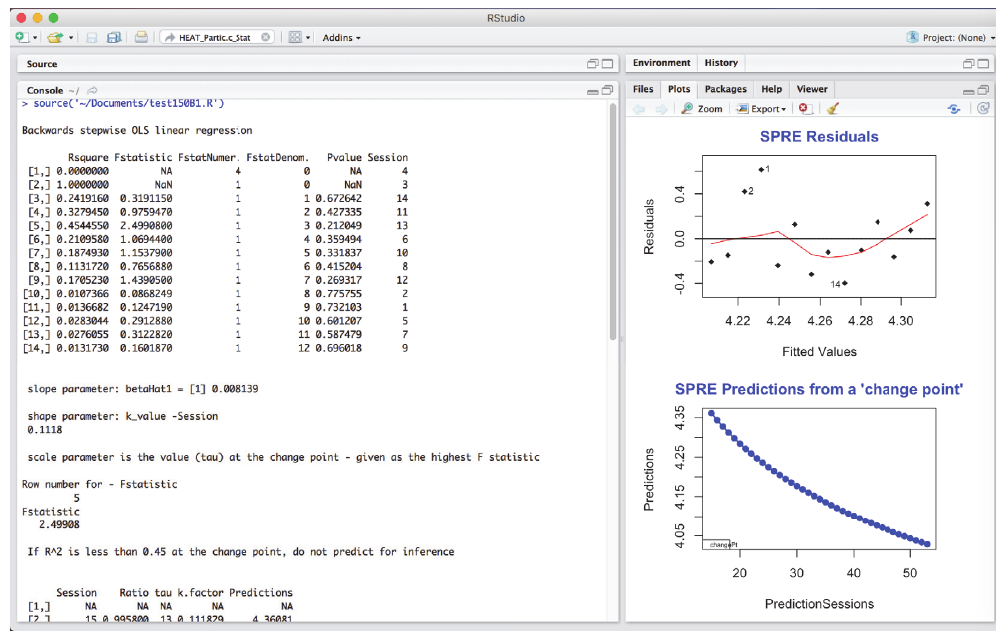
Figure 5: HEAT residuals analysis for Partic.c Static posture in SPRE.